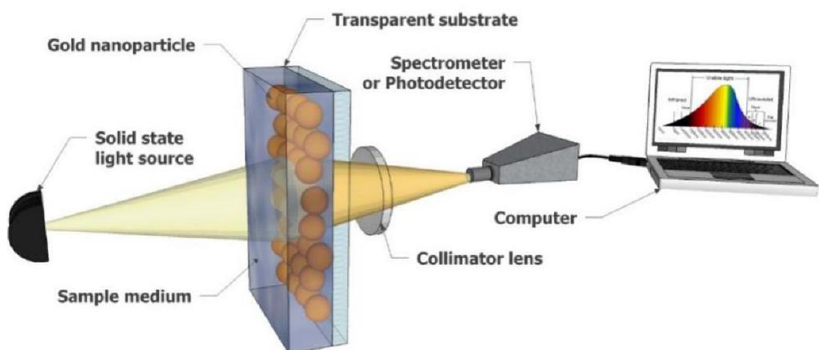
Figure 11. LSPR-based sensor using transmission attenuation configuration. Reproduced with permission from [94]. Copyright MDPI, 2018.